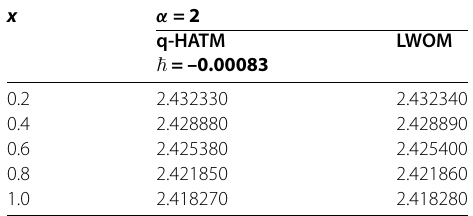
Table 3 Comparison of LWOM with q-HATM [22] at σ = 0.1, t = 1, and n =